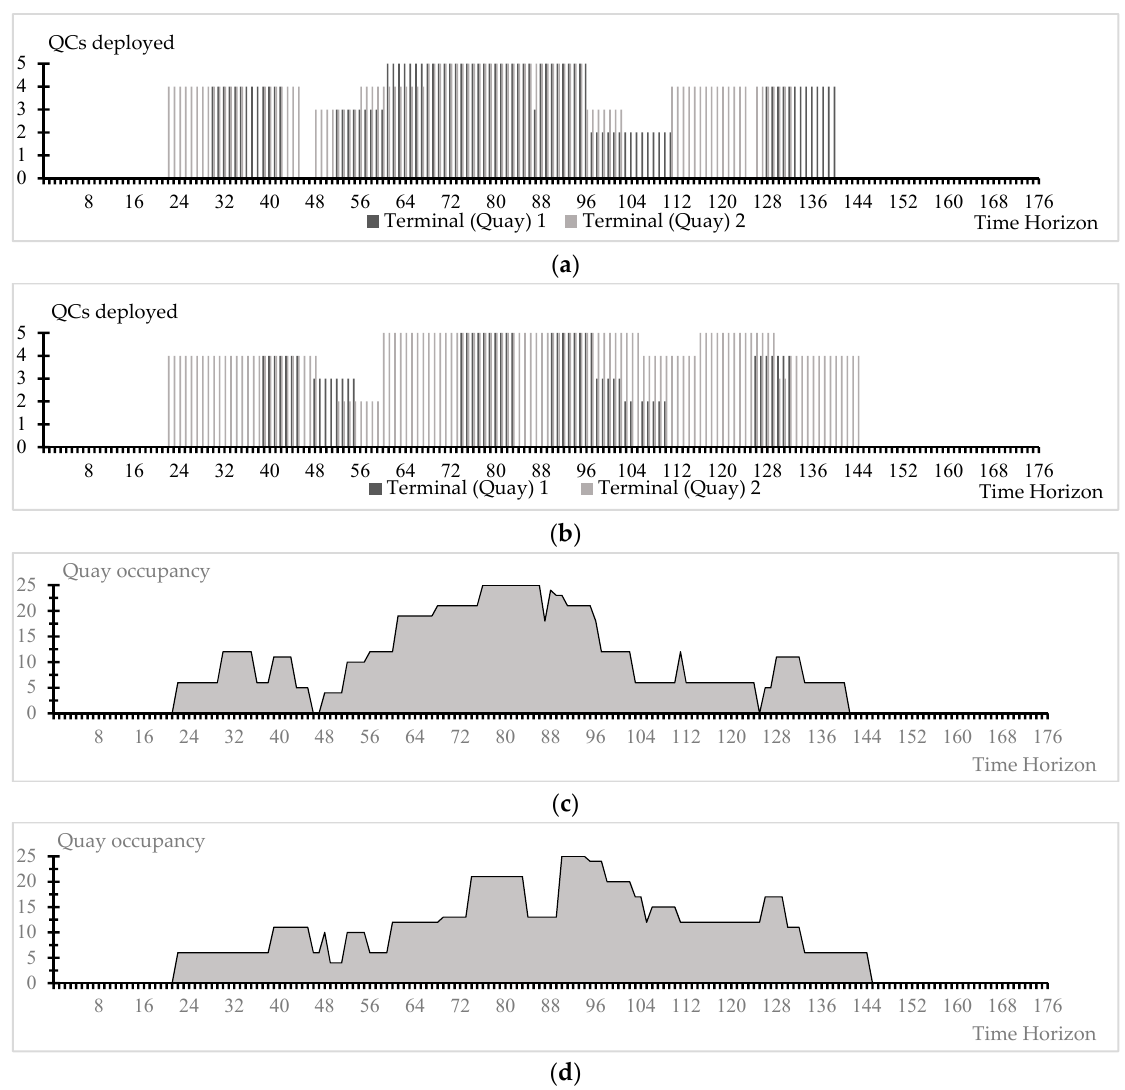
Figure 7. Comparison of resource utilization for Case 17: ( a , c ) integrated model implementation with early arrival adjustment; ( b , d ) classical approach—first in, first serve—with terminal preference.